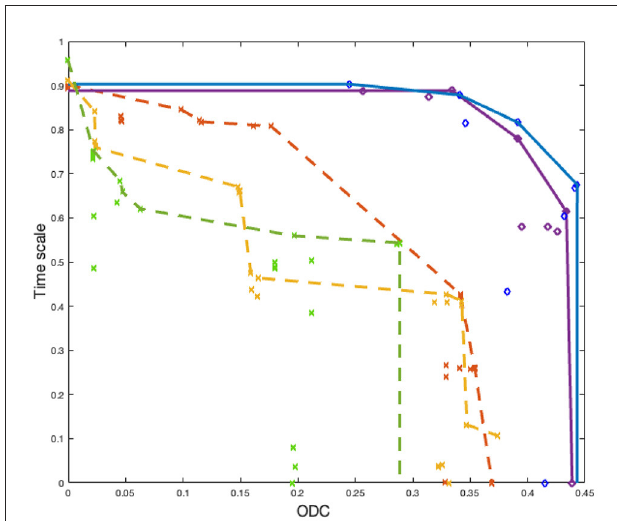
FIGURE8 Pareto fronts derived from NEDECO-PSO-CellSort (solid lines) vs. NSGA-II-CellSort (dotted lines). Dots having the same color represent solutions derived from the same experiment. Pareto fronts are generated based on sets of dots having the same